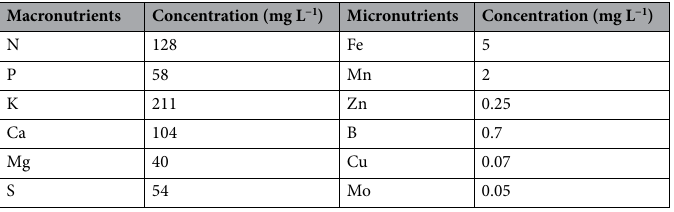
Table 1. The concentration of nutrients used in the nutrient solution of this